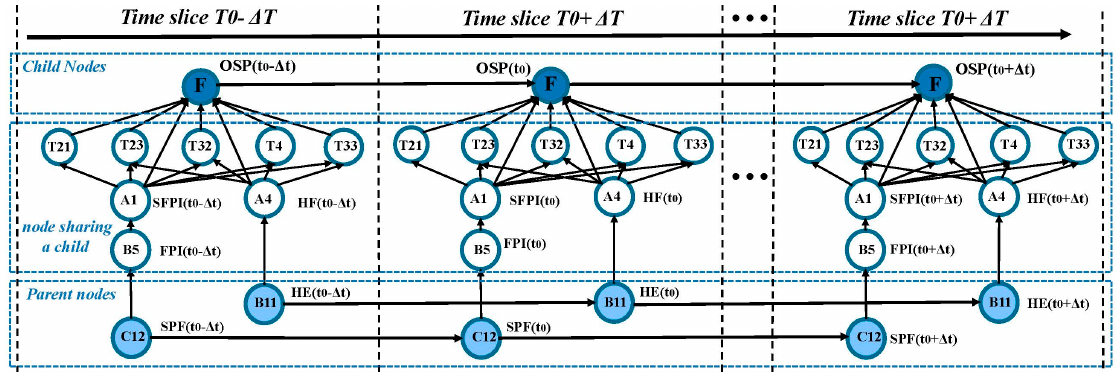
Figure 12. Simplified DBN structure for deep foundation construction in adjacent existing under- pass